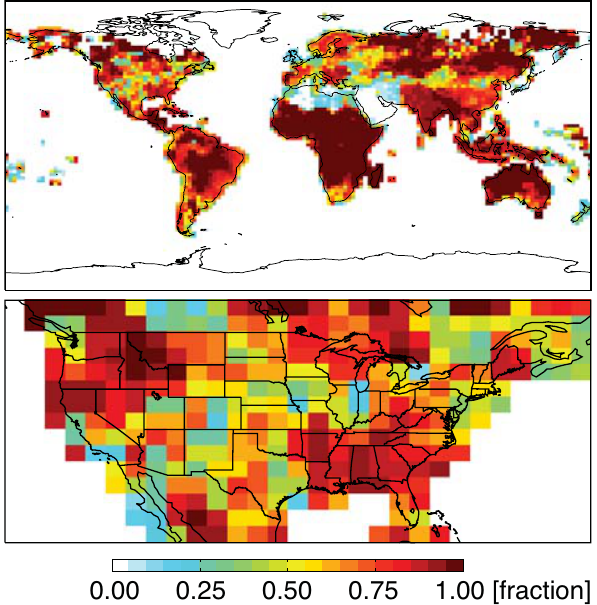
Fig. 11. Fraction of SVOC emissions from modern carbon: (Biomass + Biofuel) / (Biomass + Biofuel +